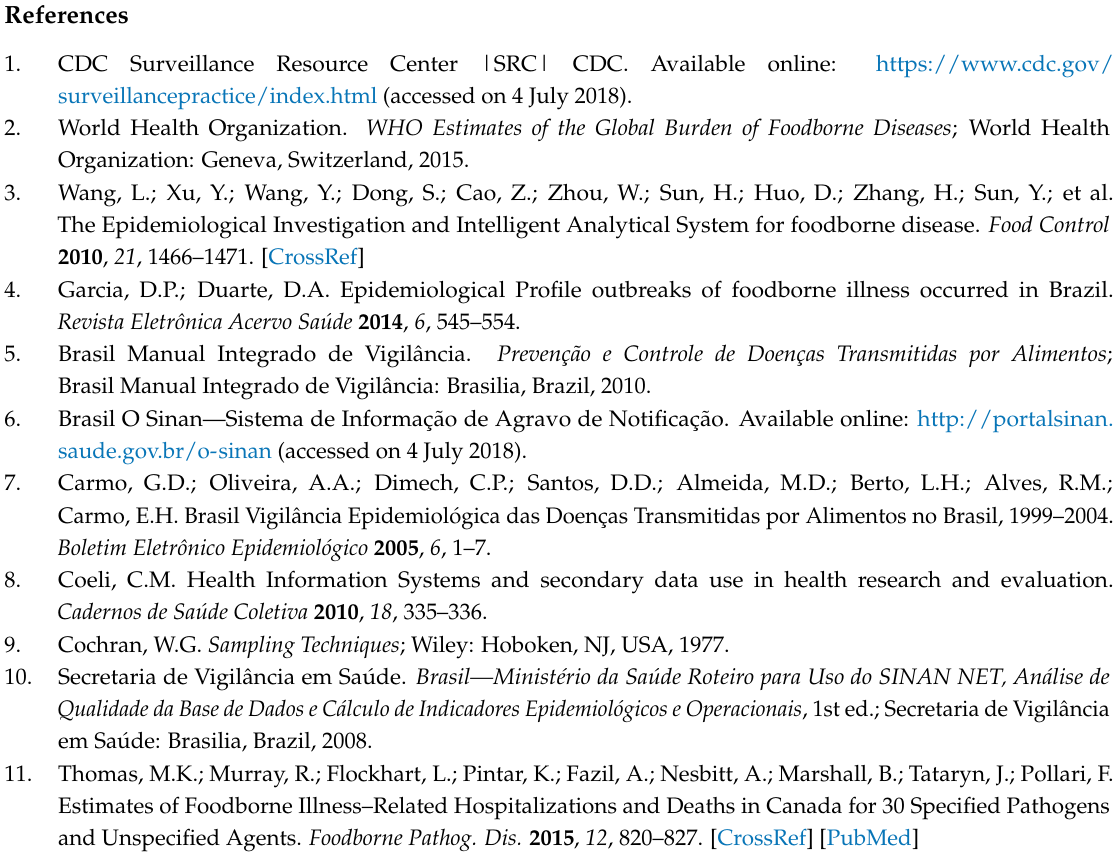
Figure S1: Mean time and standard deviation of outbreak investigation between the years 2007 and